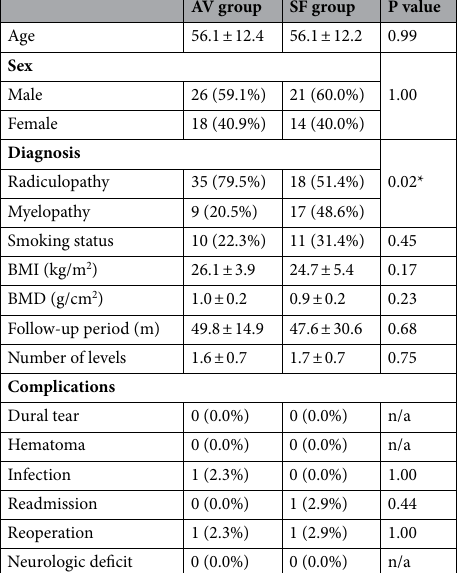
Table 1. Patient characteristics. Age, BMI, follow-up period, number of levels were analyzed using a student’s t-test. Sex, diagnosis, smoking status, complications were analyzed using a chi-square test. AV all variable,